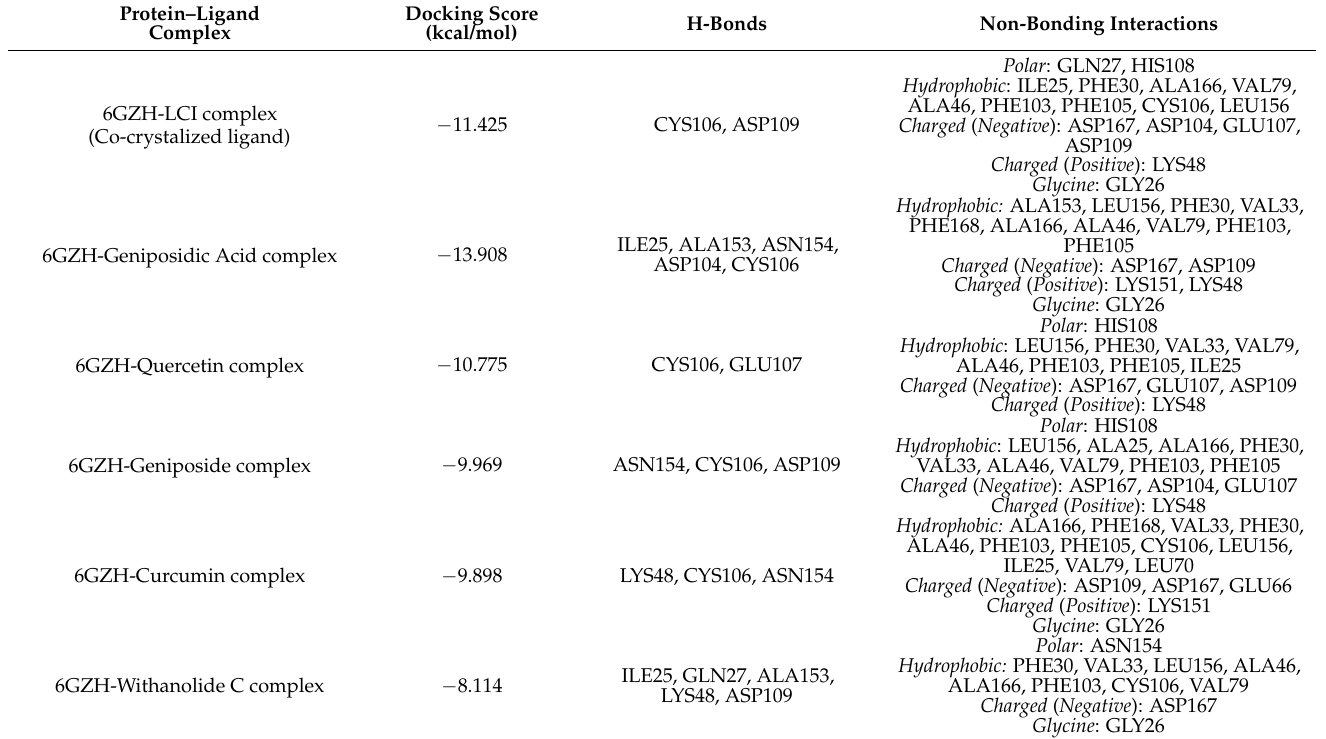
Table 1. The XP docking scores with different binding